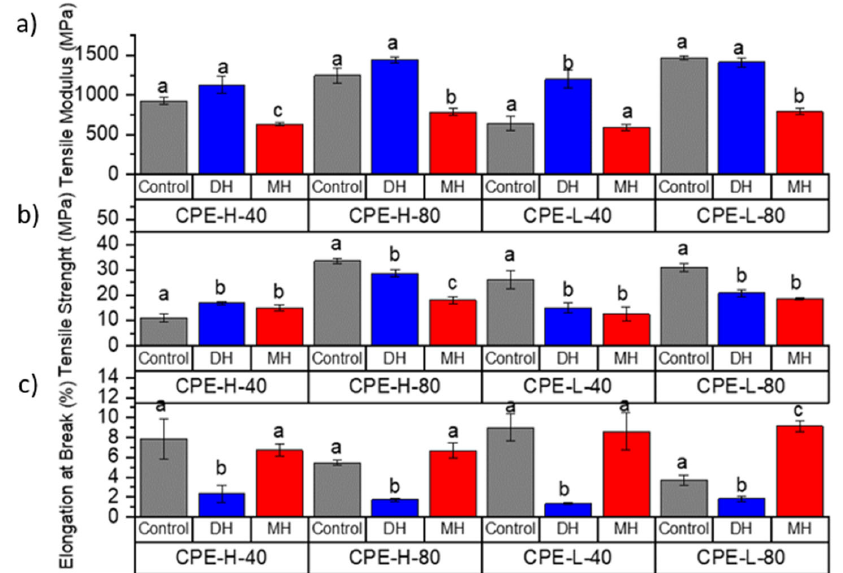
Figure 6. Change in the tensile modulus ( a ), tensile strength ( b ) and elongation at break ( c ) of the FDM dumbbells due to the DH or MH sterilization process as measured in the CPE. Grey bar: control sample; blue bar: dry heat sterilization; and red bar: moist heat sterilization. a–c Different letters show statistically significant differences between formulations ( p < 0.05).